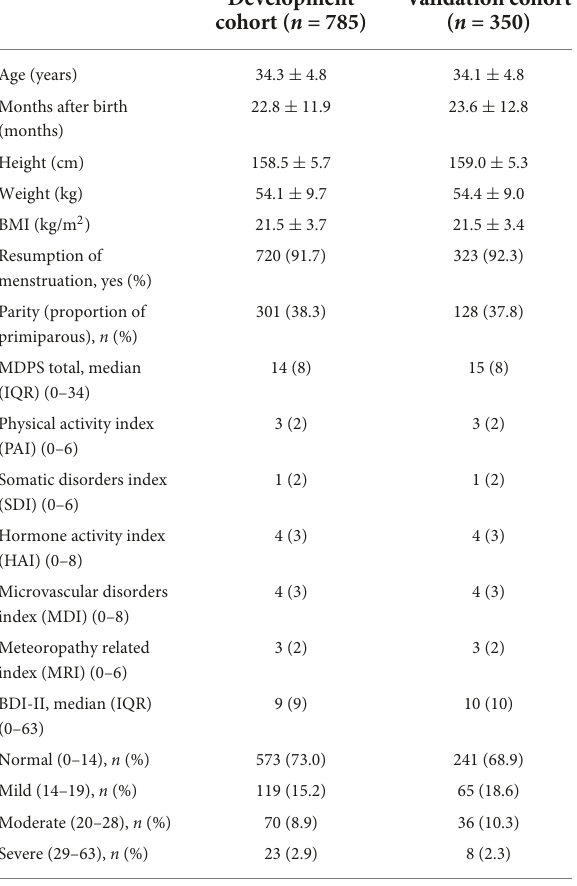
TABLE 2 Subject characteristics in the development and validation cohort.